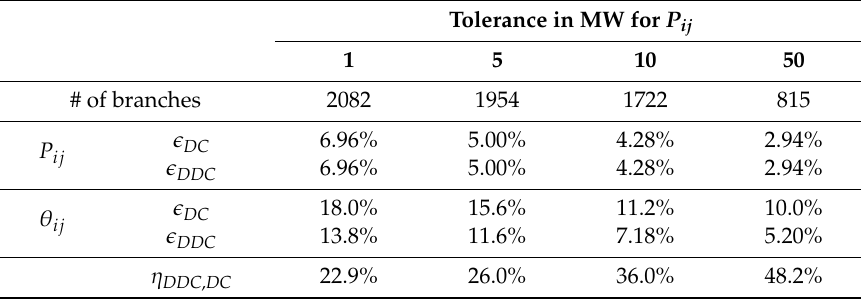
Table 2. Results with DDC and DC Models for Hour 2